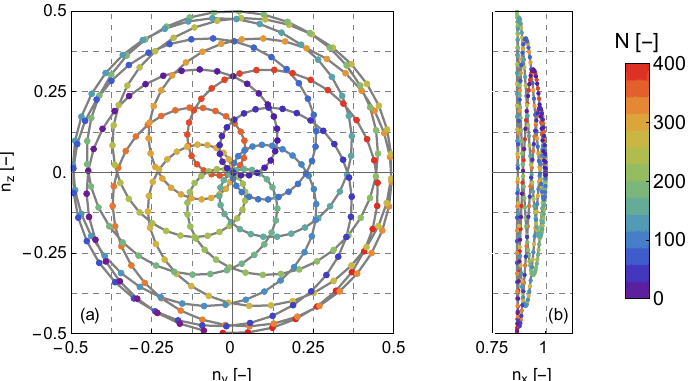
Figure 2. ( a ) Front and ( b ) side view of the scanning pattern of the SpinnerLidar . The scanning pattern is presented in terms of the unit vector components of each line-of-sight. The colour of each line-of-sight measurement (presented with a dot) corresponds to the data acquisition order, when a sampling frequency of 200 Hz is used, in combination with a scanning duration of two